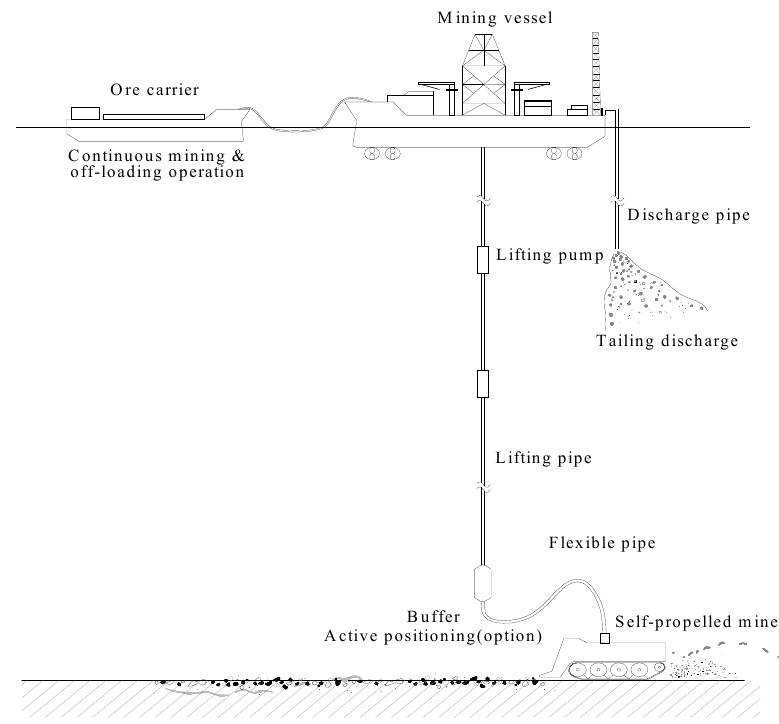
Figure 1. Continuous system concept for deep-seabed resources mining [11].